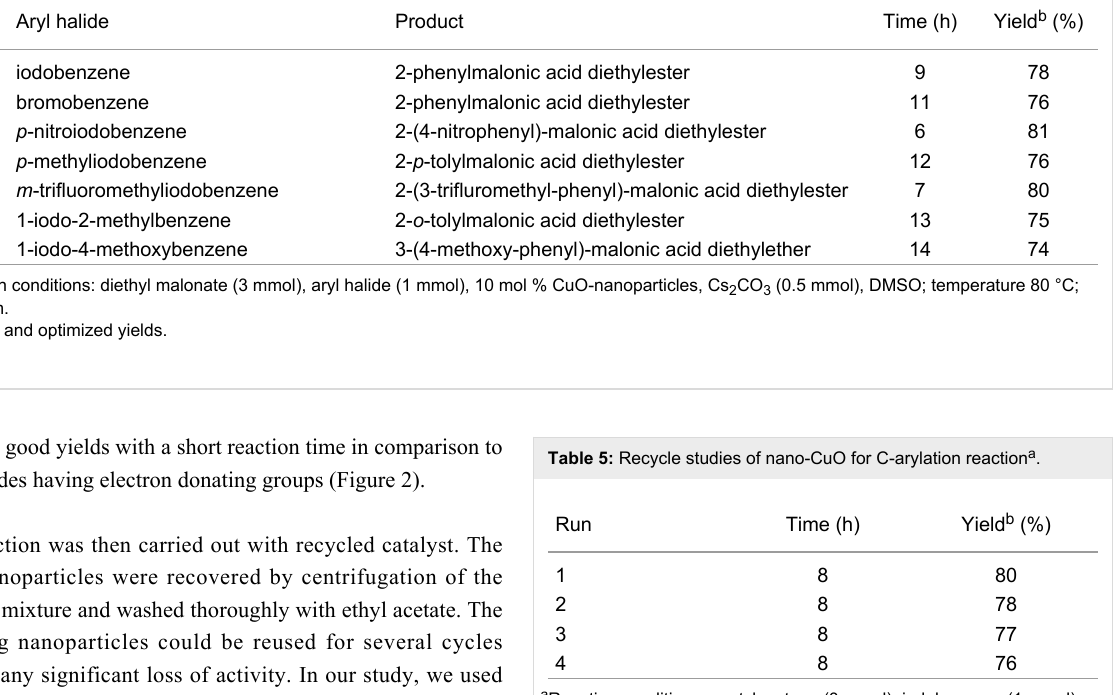
Table 4: C-arylation of diethyl malonate using different aryl halides a . Entry Aryl halide